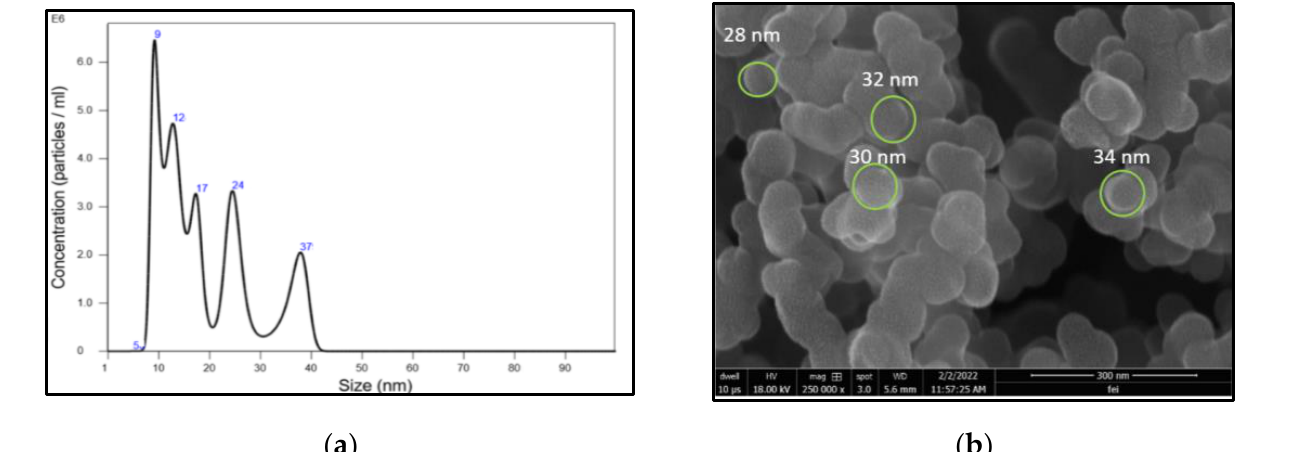
Figure 3. ( a ) NTA (Nanosight-LM-20) nanoparticle size distribution histogram showing the average size of 15.4 nm; ( b ) FESEM image of CDs at 250,000× resolution.